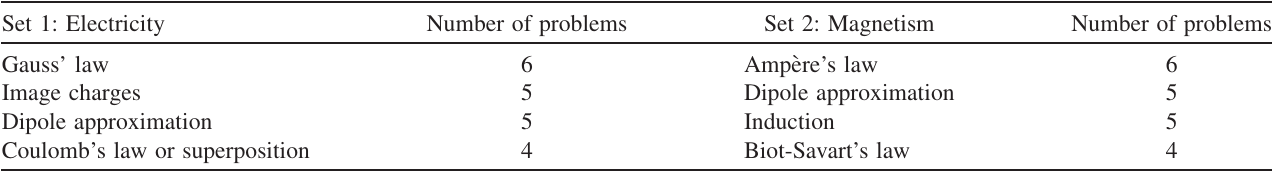
CHOOSING THE RIGHT SOLUTION . . TABLE II. Distribution of the problems over topics according to the experimenters. Set 1: Electricity